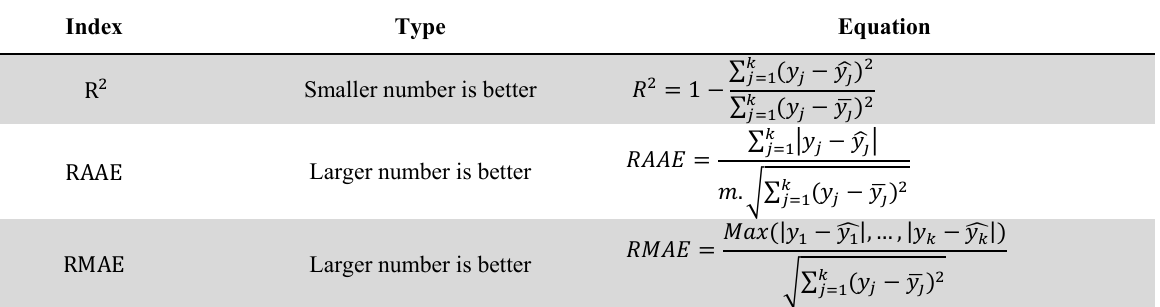
Metamodels measurement